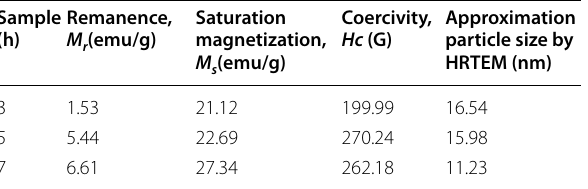
Table 1 The remanence ( M ), saturation magnetization ( M r coercivity ( H ) and TEM particle size of MNA nano-absorbent c Sample (h)